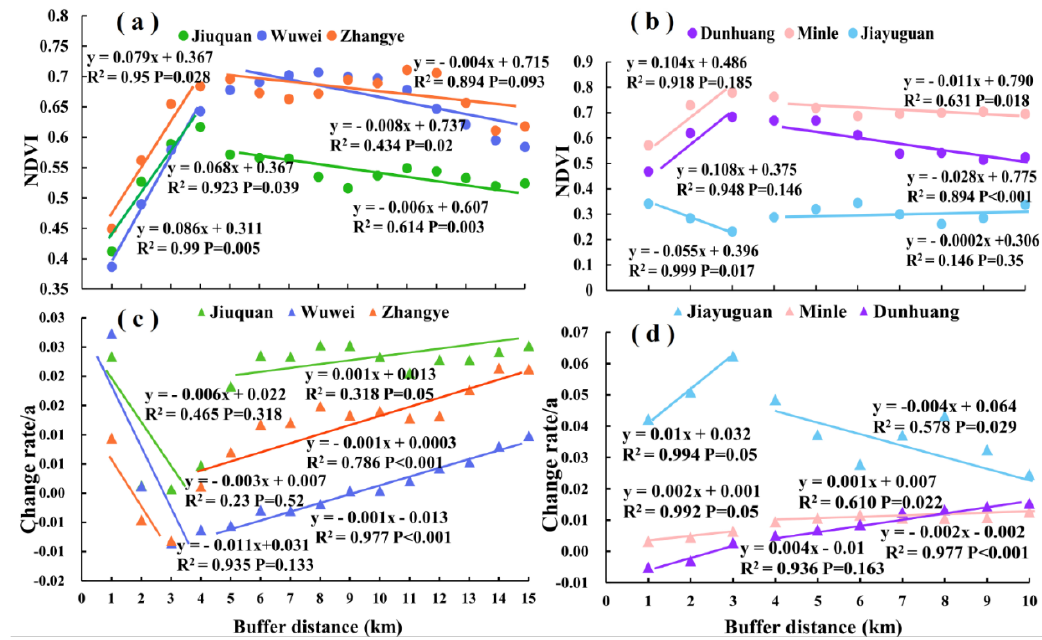
Figure 8. The change process of the growing season mean NDVI ( a and b ) and the linear change rate ( c and d ) from 2000 to 2015, with the distance to city and county administration center in the range of human activities,